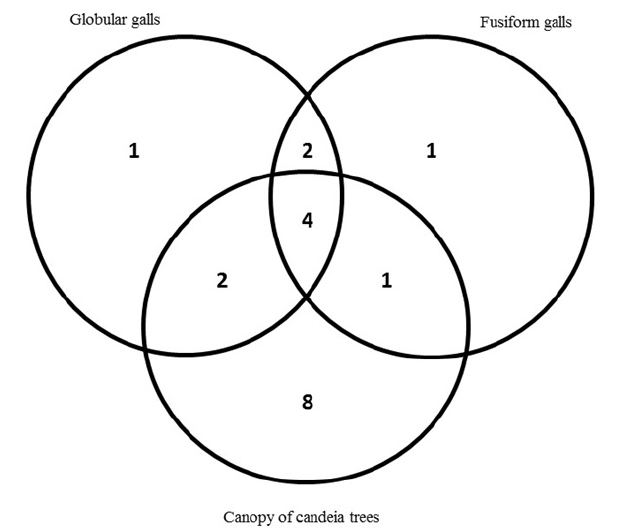
Fig 2 . Venn diagram showing number of ant species found in galls of the two morphotypes and in canopies of candeia